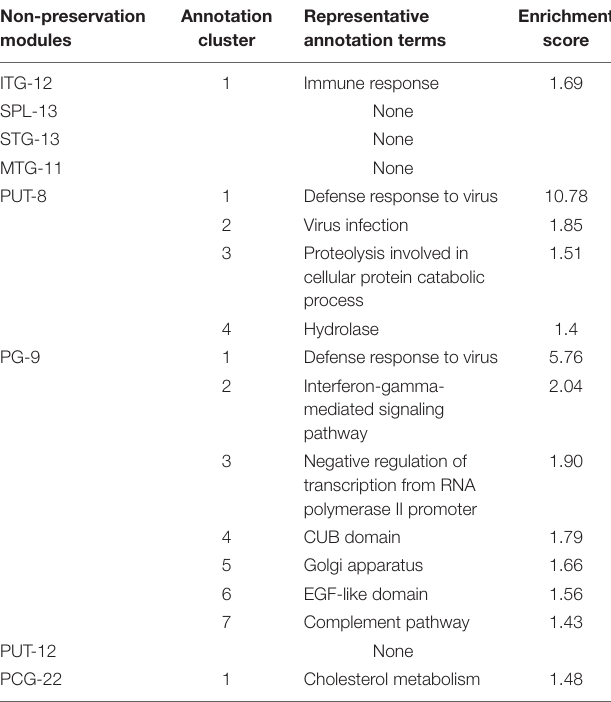
TABLE 2 | Pathway clusters significantly enriched by genes of non-preservation modules (enrichment score > 1.3).